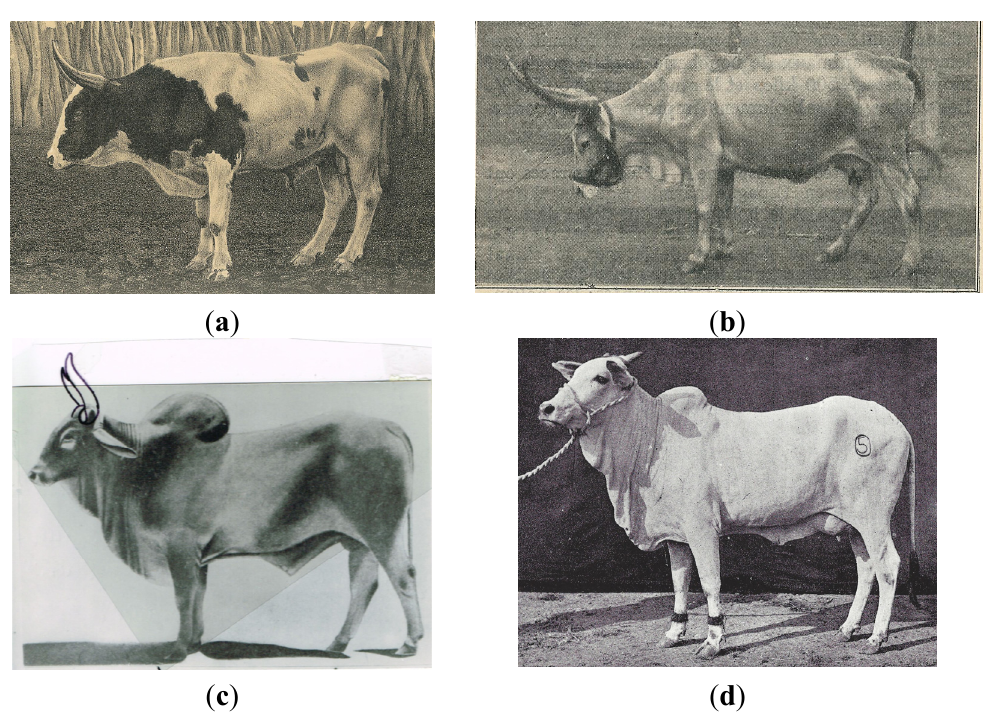
Figure 22. Criollo and zebu breeds. ( a ) Mexican Criollo bull [149]; ( b ) Brazilian